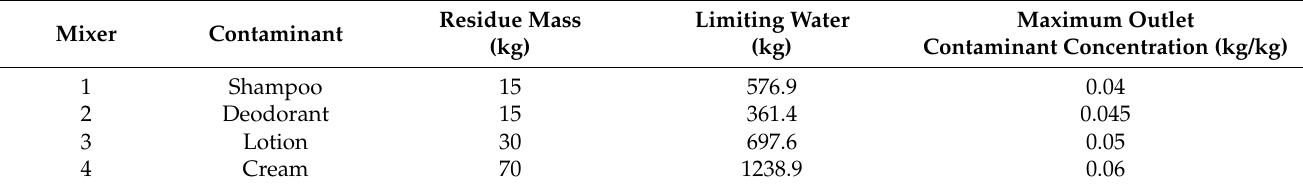
Table A11. Wastewater minimization data for case study 4 [11].